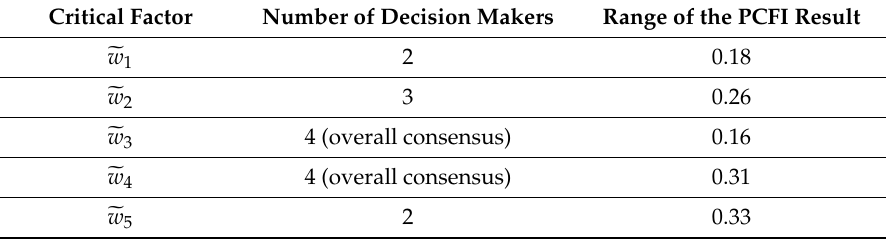
Figure 9. The partial consensus fuzzy intersection (PCFI) results. Table 5. The number of decision makers achieving a partial consensus for each critical factor.